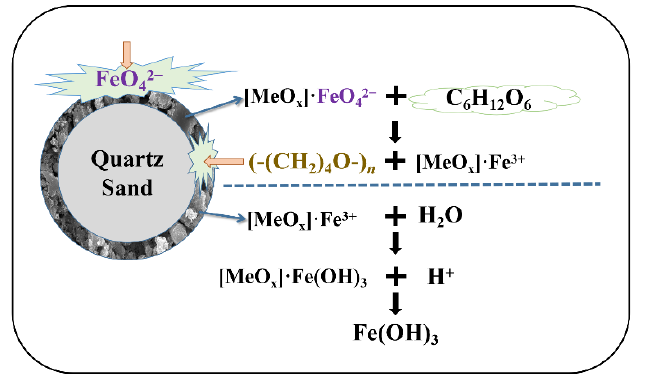
Figure 9. Mechanism of K 2 FeO 4 -enhanced MeO x removal of COD Mn .